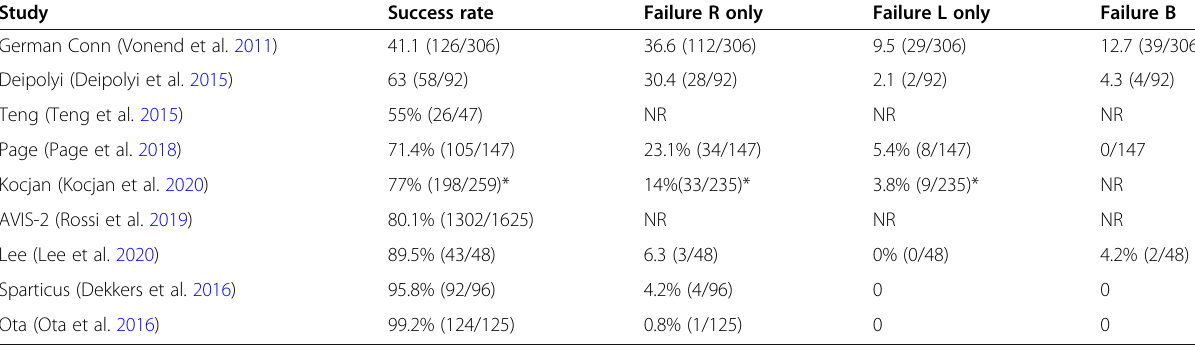
Table 4 Success and Failure Rate of Recently Published AVS studies Study Success rate Failure R only Failure L only German Conn (Vonend et al. 2011)